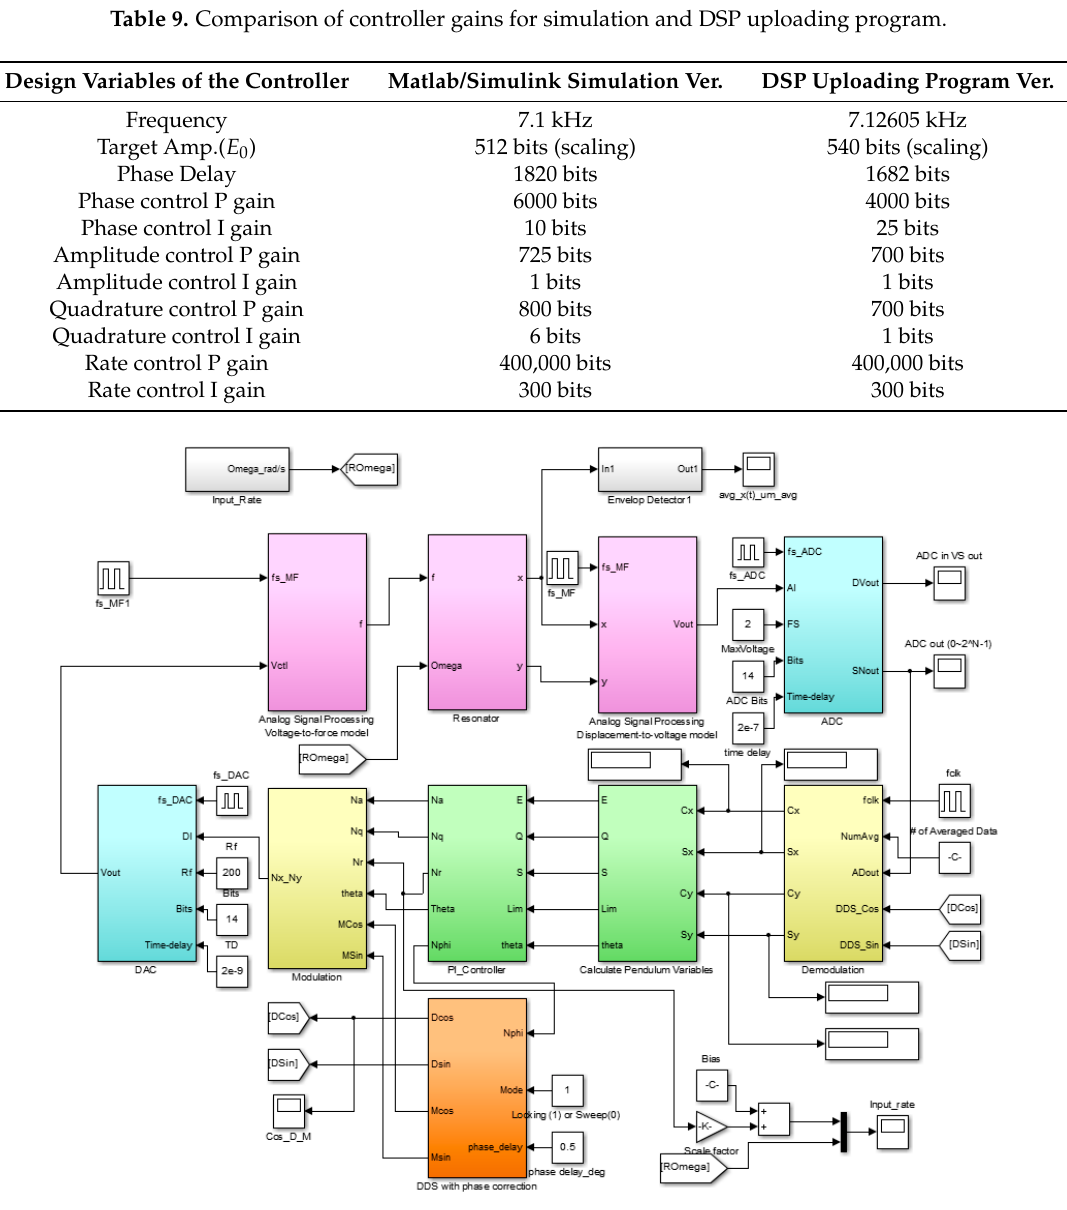
Figure 12. Matlab/Simulink simulation program to verify the signal processing and control algorithm. The simulation results are shown in Figures 13 and 14. The amplitude control variable is converged to the target amplitude (cid:1831) (cid:2868) = 512 bits (= 1 μm (cid:2870) ) and the rate control variable is converged